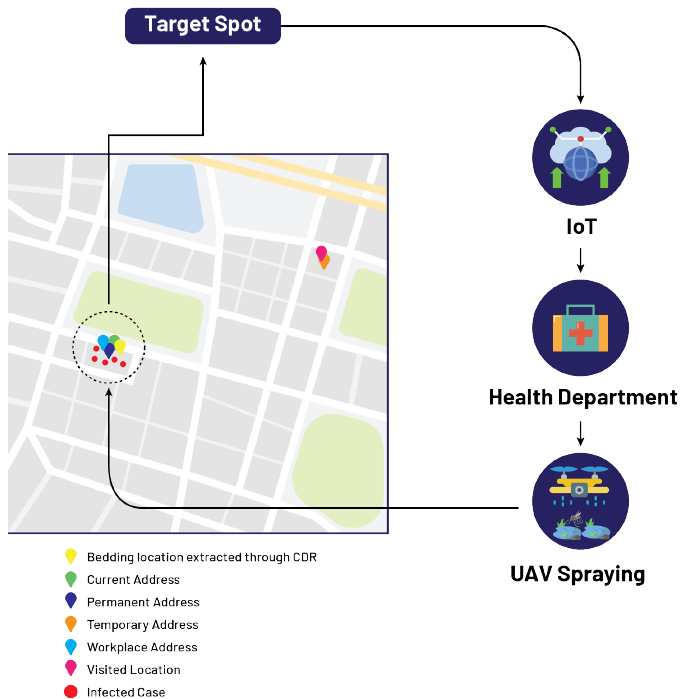
Figure 5. Localization of target spot based on proposed model.